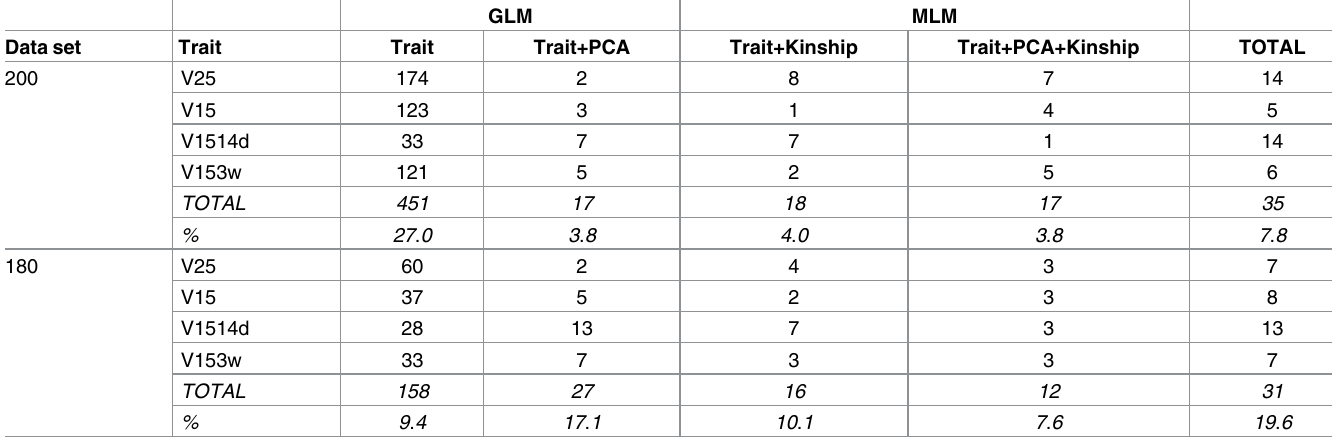
of different levels of population structure and relatedness can effectively eliminate the excess of low p -values but it also likely eliminate true positives, we analysed all the SNPs detected for each trait under any model with a p -value < 0.001. The individual effects, positive and nega- tive, of the detected markers on the phenotype were low (r 2 = 0.067 on average), but contrib- uted to explain the observed variability, since significant Spearman correlation coefficients were estimated for the number of favourable alleles in each panel of markers and the respective trait (data not shown). The genetic model also affected the significance of the detected marker- trait associations, especially for the complete data set and for PCA- based (GLM and MLM) or MLM-K models (S1 Fig). Most of the associated markers, however, were significantly detected in more than one approach, for example when using models with the two different kinship matrices. The effect of genetic structure on association analyses was different for the four traits: MLM-K detected more markers significantly associated to V25 than the two models that included PCA as a covariate, probably indicating an overestimated effect of population struc- ture for this trait, for which the highest values were observed in both indica and japonica Table 3. Number of markers,from the 1672 panel of SNPs, associated with the four analysed traits ( p < 0.001) detected under three different mod- els that control false associations (GLM-PCA, MLM-K and MLM-PCA+K), and percentages of associated markersreferredto those detected in the phenotype analysis